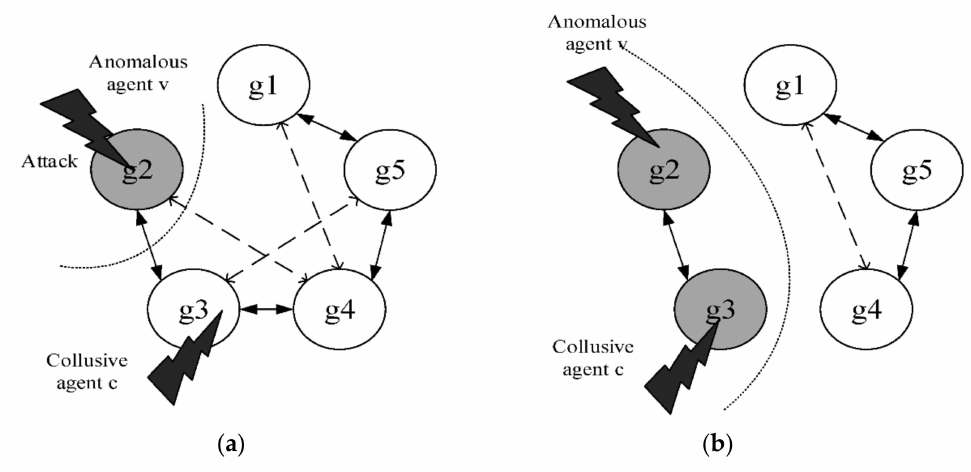
Figure 7. Diagrams of the isolation of colluding attacks. ( a ) The abnormally behaving agent v collides with the normal c; ( b ) Isolate abnormal agents v and